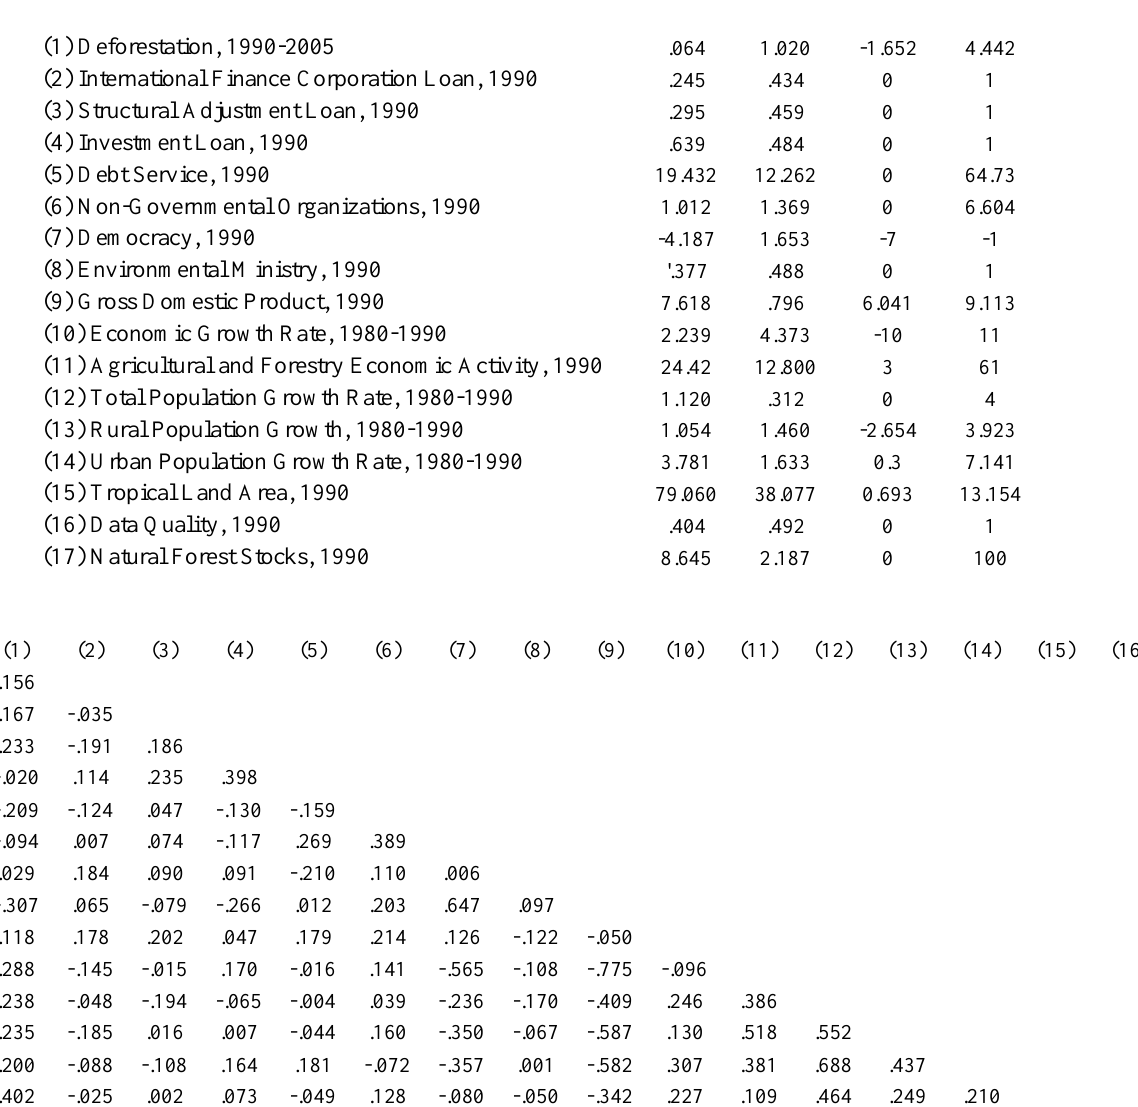
Mean SD Min. Max.